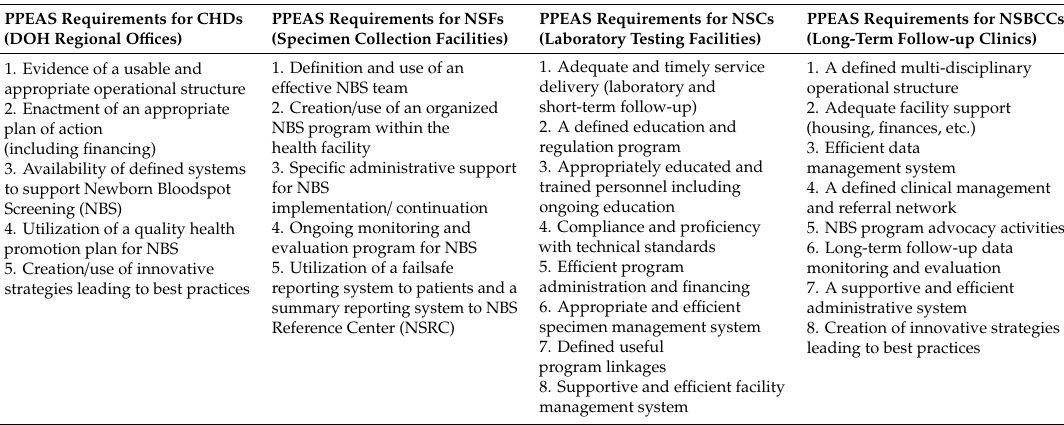
Table 1. Summation of the requirements of various Philippines performance evaluation and assessment schemes (PPEAS) by